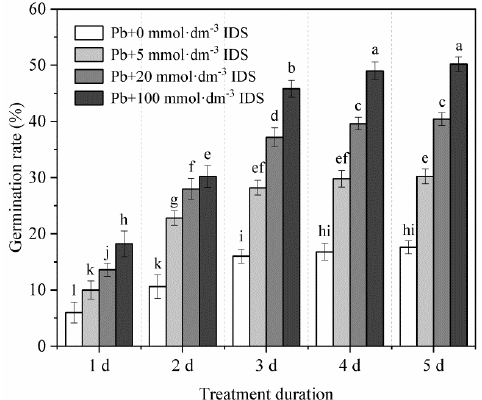
Figure 2. Effects of IDS on maize seed germination under Pb stress. Maize seeds were treated with 20 mmol · dm − 3 PbCl 2 + 0 mmol · dm − 3 IDS, 20 mmol · dm − 3 PbCl 2 + 5 mmol · dm − 3 IDS, 20 mmol · dm − 3 PbCl 2 + 20 mmol · dm − 3 IDS, or 20 mmol · dm − 3 PbCl 2 + 100 mmol · dm − 3 IDS solu- tions. The number of germinated maize seeds was recorded at 1, 2, 3, 4, and 5 d after sowing. Error bars represent the standard deviation of the mean ( n = 5). Means associated with different letters are significantly different between treatments and time points ( p < 0.05 level; Duncan’s new multiple range test). IDS, iminodisuccinic acid; Pb,